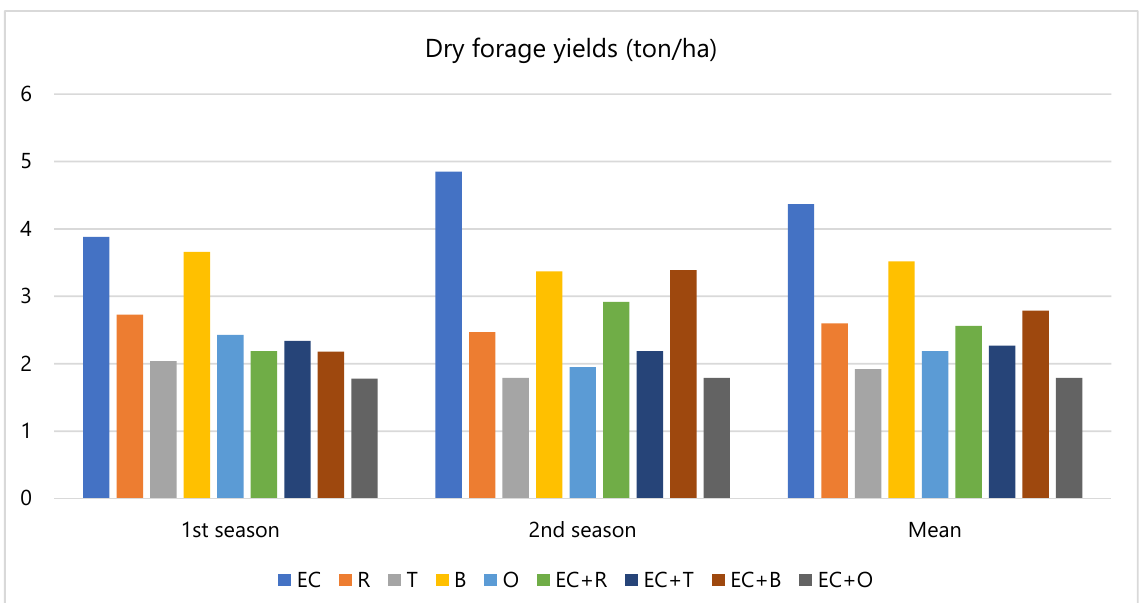
Figure 3. Means of dry forage yields (ton/ha) produced from the different studied forages in each season of the study. EC = Egyptian clover monoculture, R = ryegrass monoculture, T = triticale monoculture, B = barley monoculture, O = oat monoculture, EC+R = Egyptian clover + ryegrass intercropping, EC+O = Egyptian clover + oat intercropping, EC+B = Egyptian clover + barley intercropping, and EC+T = Egyptian clover + triticale intercropping (L.S.D. season = 0.47, L.S.D. forages = 1.72, and L.S.D. forage×season = 0.860).